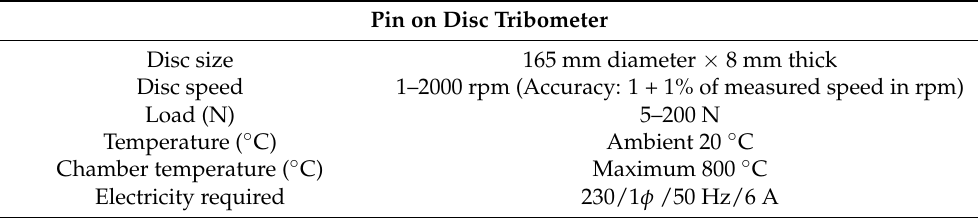
Table 1. Specifications: Pin on disc tribometer.